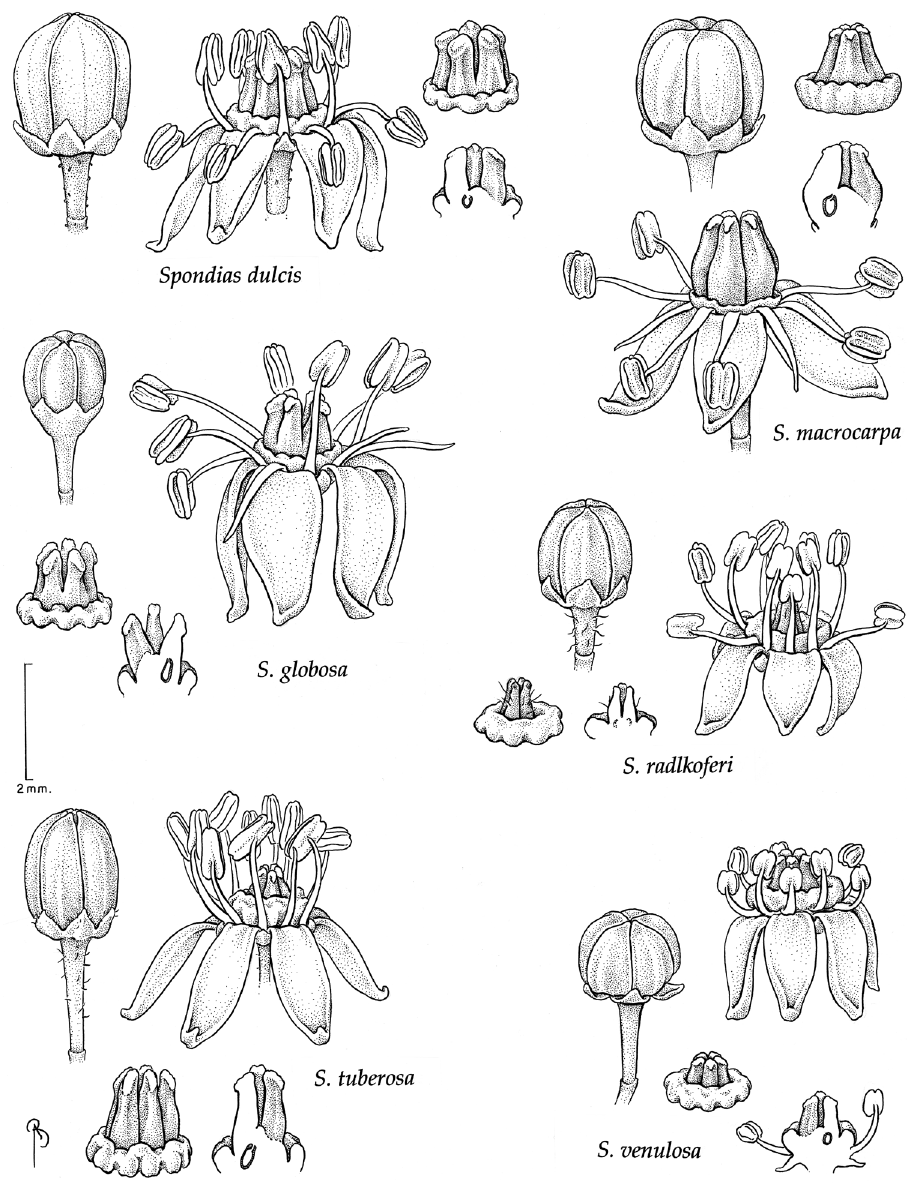
Figure 15. Flowers of Spondias species: Spondias dulcis ( Wurdack 315 , NY); S. macrocarpa ( Spada 013/77 , NY); S. globosa ( Daly et al. 7836 , NY); S. radlkoferi ( Heithaus 119 , NY); S. testudinis ( Lao Magín 112 , NY); S. tuberosa ( Carauta 552 , NY); S. venulosa ( Queiroz 2604 ,